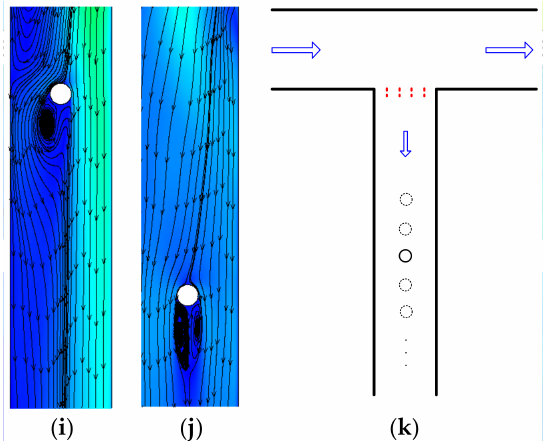
Figure 10. Global flow structure around the circular cylinder at R = 0.117 without vanes: ( a ) z / D h = 0.5; ( b ) z / D h = 1; ( c ) z / D h = 1.5; ( d ) z / D h = 2; ( e ) z / D h = 3; ( f ) z / D h = 4; ( g ) z / D h = 5; ( h ) z / D h = 6; ( i ) z / D h = 7; ( j ) z / D h = 9 and ( k ) schematic figure of the T pipe